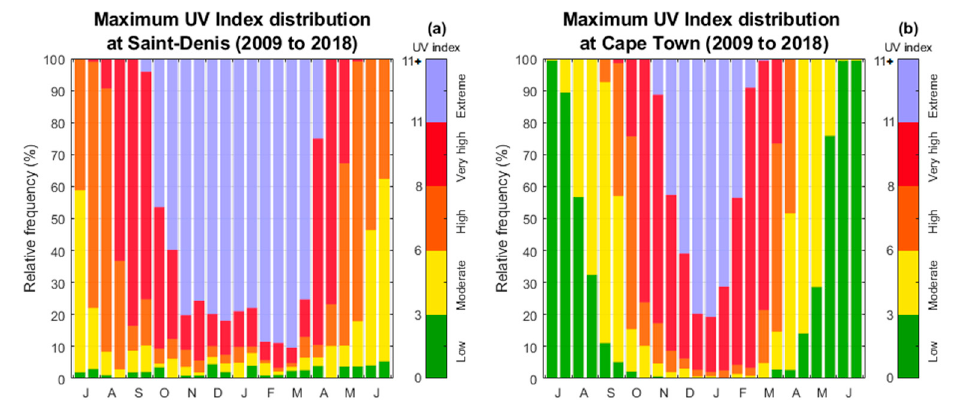
Figure 4. Relative frequency of ultraviolet (UV) index thresholds (WHO) based on the half-month maximum UV Index (UVI) over the decade (2009 to 2018), ( a ) for Saint-Denis UV station and ( b ) for Cape Town UV station. Months on the X-axis have been reorganized to highlight the austral summer, which appears in the middle of the plot.